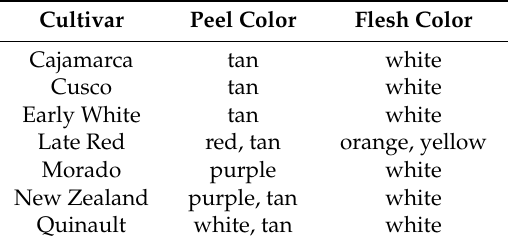
Table 6. Color of the peel and the flesh of yacon tubers from different cultivars.